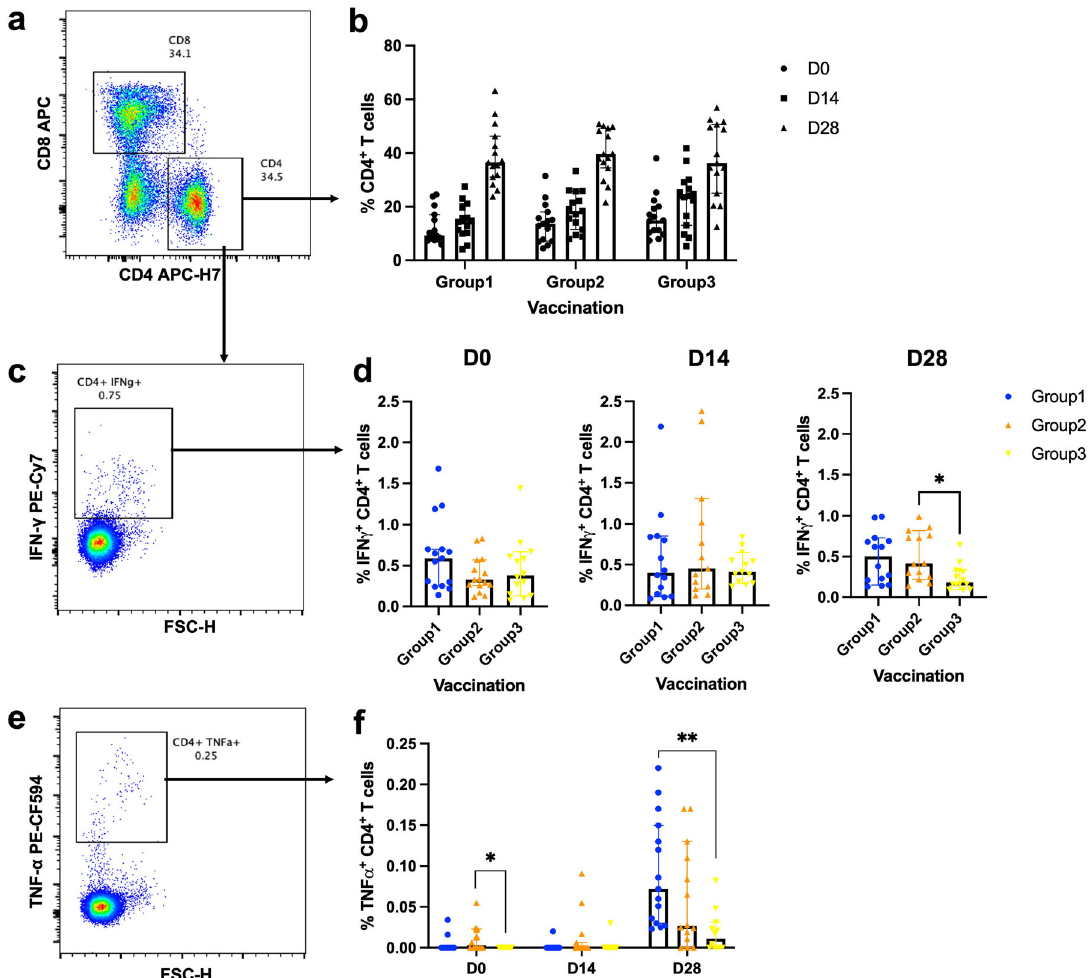
Fig. 7 Effector cytokine production of S1-speci fi c CD4 + T cells after boosting. All volunteers were previously completed with two doses of inactivated SARS-CoV-2 vaccines. A full dose of intramuscular viral vector booster was given at 4 – 8 weeks after their last vaccination (Group 1). After 4 – 8 weeks (Group2) and 8 – 12 weeks (Group3), the fractional dose of a viral vector vaccine booster was delivered intradermally. Blood was taken before (D0) and after the booster dose for 14, 28 days (D14, D28). The blood samples were processed to obtain PBMCs. The frozen PBMCs were thawed and stimulated with S1 peptide pools. The cells were stained and analysed using fl ow cytometry. a Representative fl ow plot shows CD8 + T cell and CD4 + T cell populations. b Percentage of CD4 + T cells before and after the booster dose. c CD4 + T cells